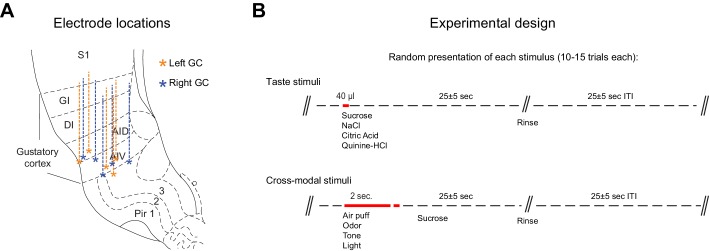
Electrode placement and experimental design for the group of trained rats.(A) Schematic representation of a coronal section of rat’s brain highlighting the dorso ventral range of recording and electrodes placement in the gustatory cortex for the right (light blue) and left (light orange) hemisphere. (B) Sketch of the experimental design for each trial. Red bars highlight stimulus delivery. See experimental procedures for further details. Each tastants is delivered through the IOCs in aliquots of 40 µl. Each cross modal stimulus is presented for 2 s. Between the cross modal stimuli offset and sucrose onset there is a constant delay of 500 ms.